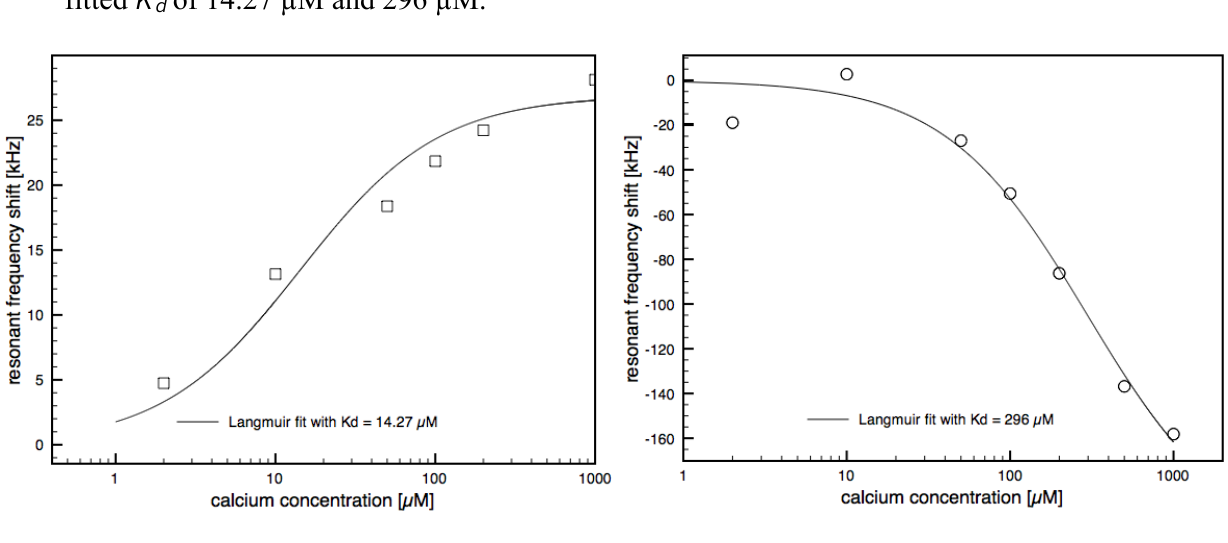
Figure 4. Frequency shift of calcium binding to calmodulin at different calcium concentrations for the two different surface concentrations of 100 ng/cm 2 ( left ) and 190 ng/cm 2 ( right ). The line shows the results of the Langmuir isothermal plots with fitted K of 14.27 µM and 296 d